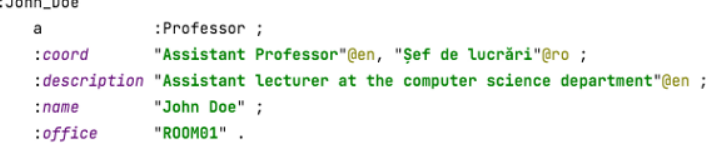
Figure 3. Professor’s information in Turtle format